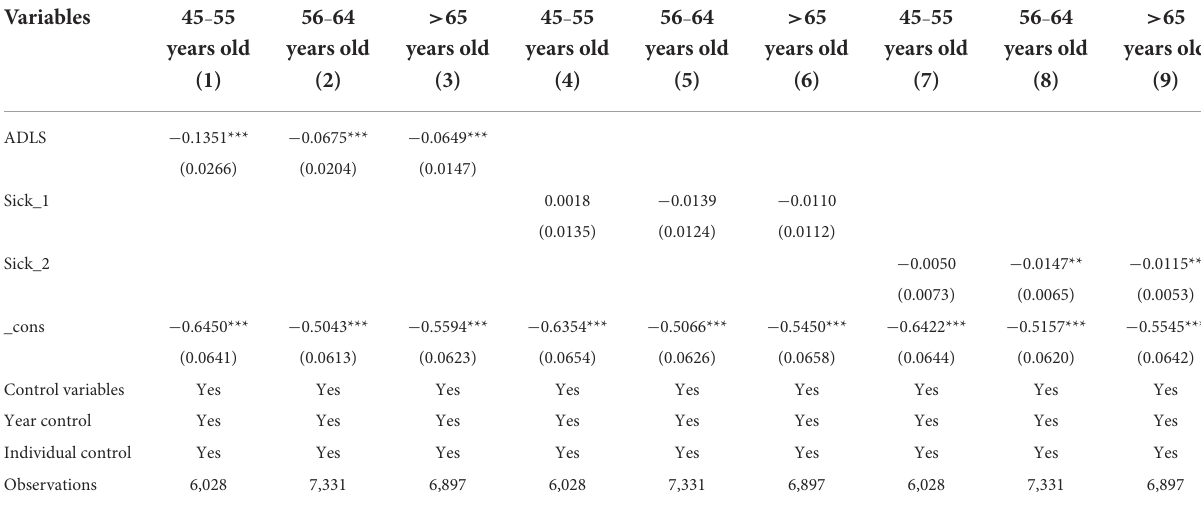
TABLE 6 Results of age groups.